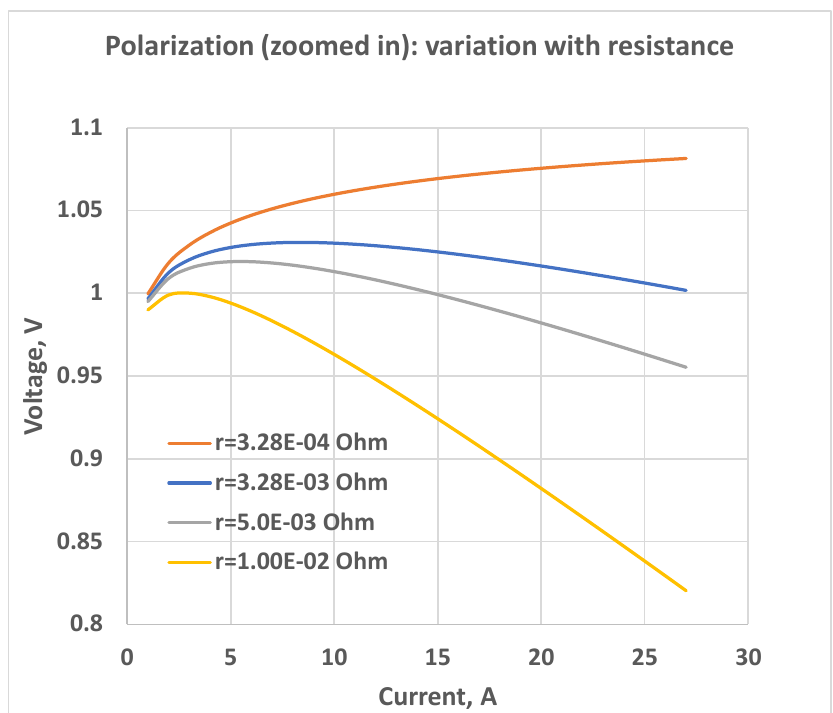
Figure 2. Zoomed in version of Figure 1 at low current values, showing changes in the